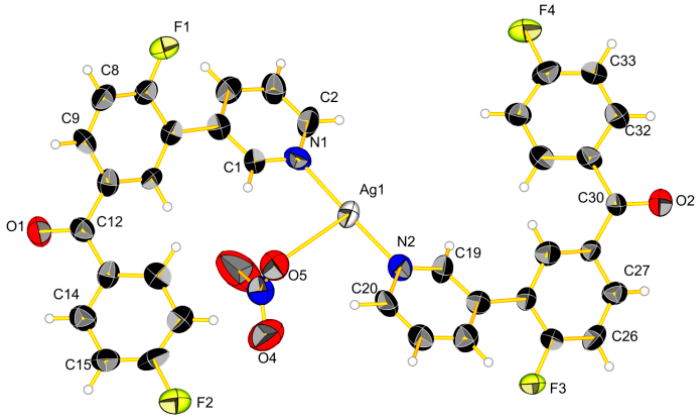
Figure 8. View of the complex 5a in ellipsoid 50% probability.